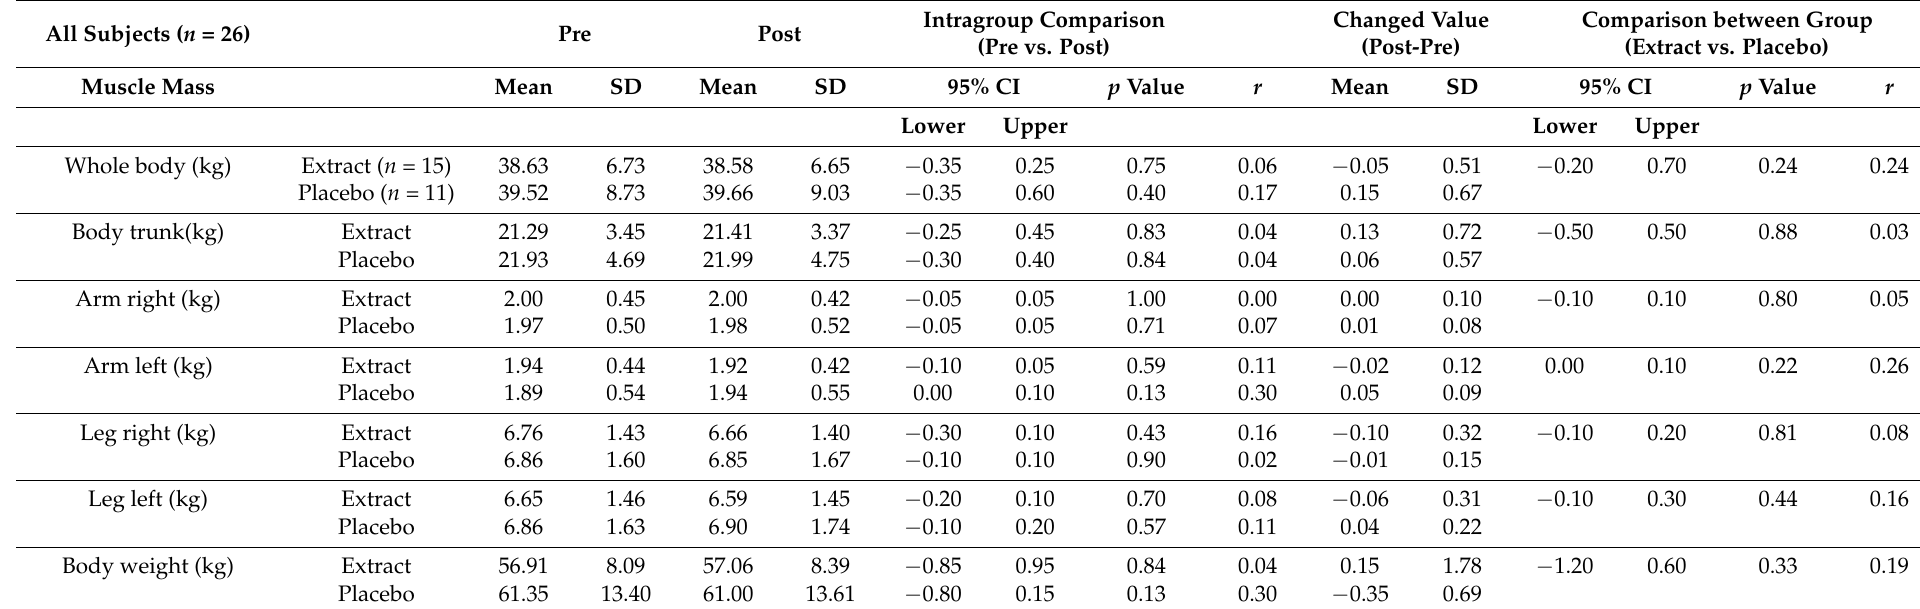
Table 3. Comparison of muscle mass and body weight in all